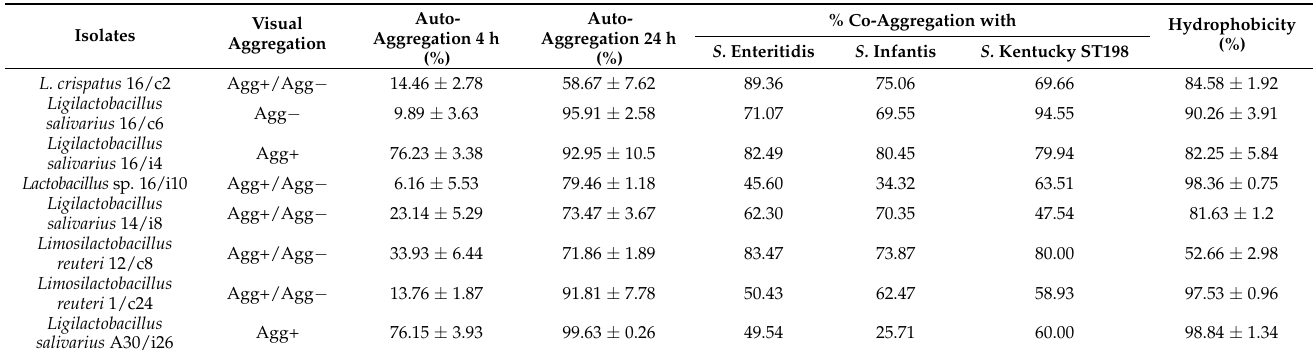
Table 1. Cell surface properties of the eight selected strains of lactobacilli.